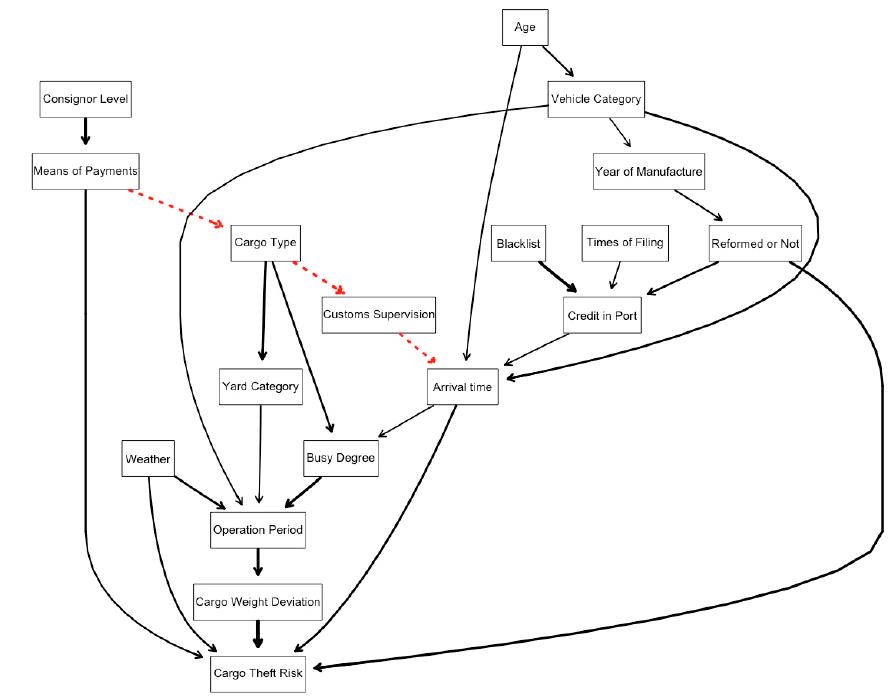
Figure A2. The Bayesian network structure derived using combinations of heuristic structure search algorithm with HC and score function with Bic.